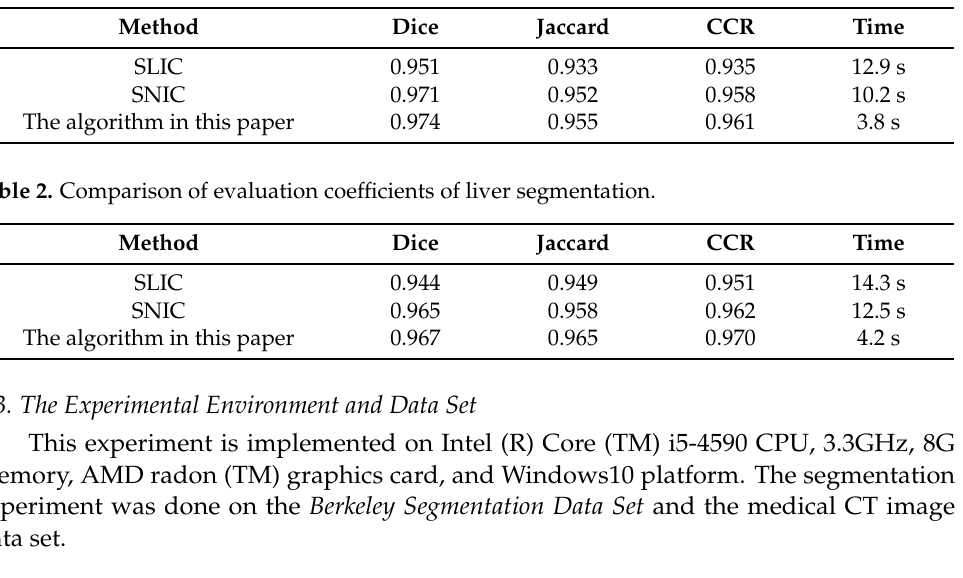
Table 1. Comparison of evaluation coefficients of vertebrae segmentation.